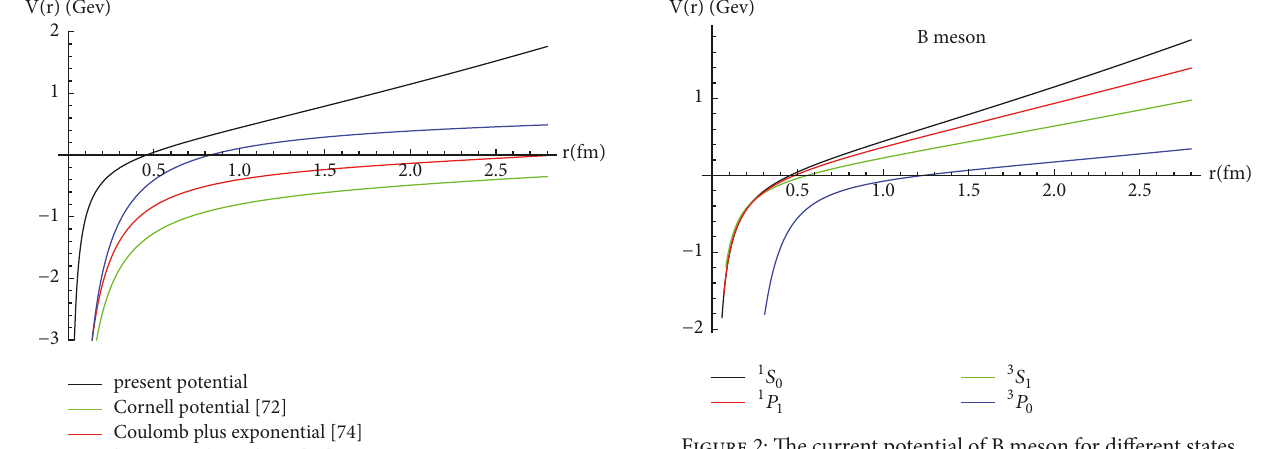
Figure 2: The current potential of B meson for different states.